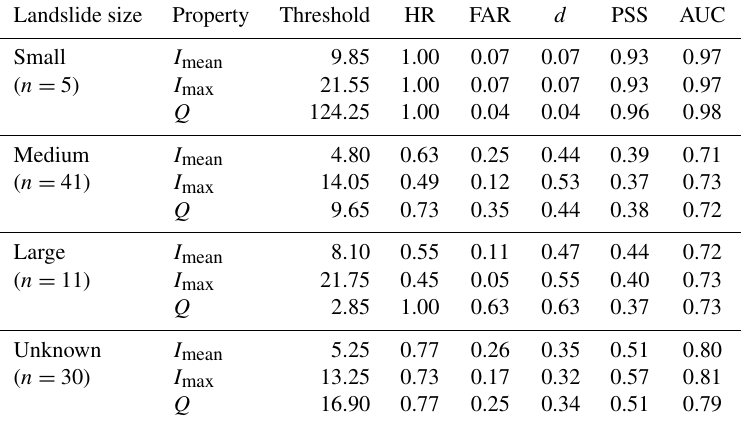
Table 2. Calibrated thresholds of I mean (mmd − 1 ), I max (mmd − 1 ), and Q (mm) for UTL events of the sum of rainfall and snowmelt (rainfall + snowmelt), as well as corresponding performance statistics for different categories of landslide size, and n refers to the number of landslides in each category. Landslide size Property Threshold HR